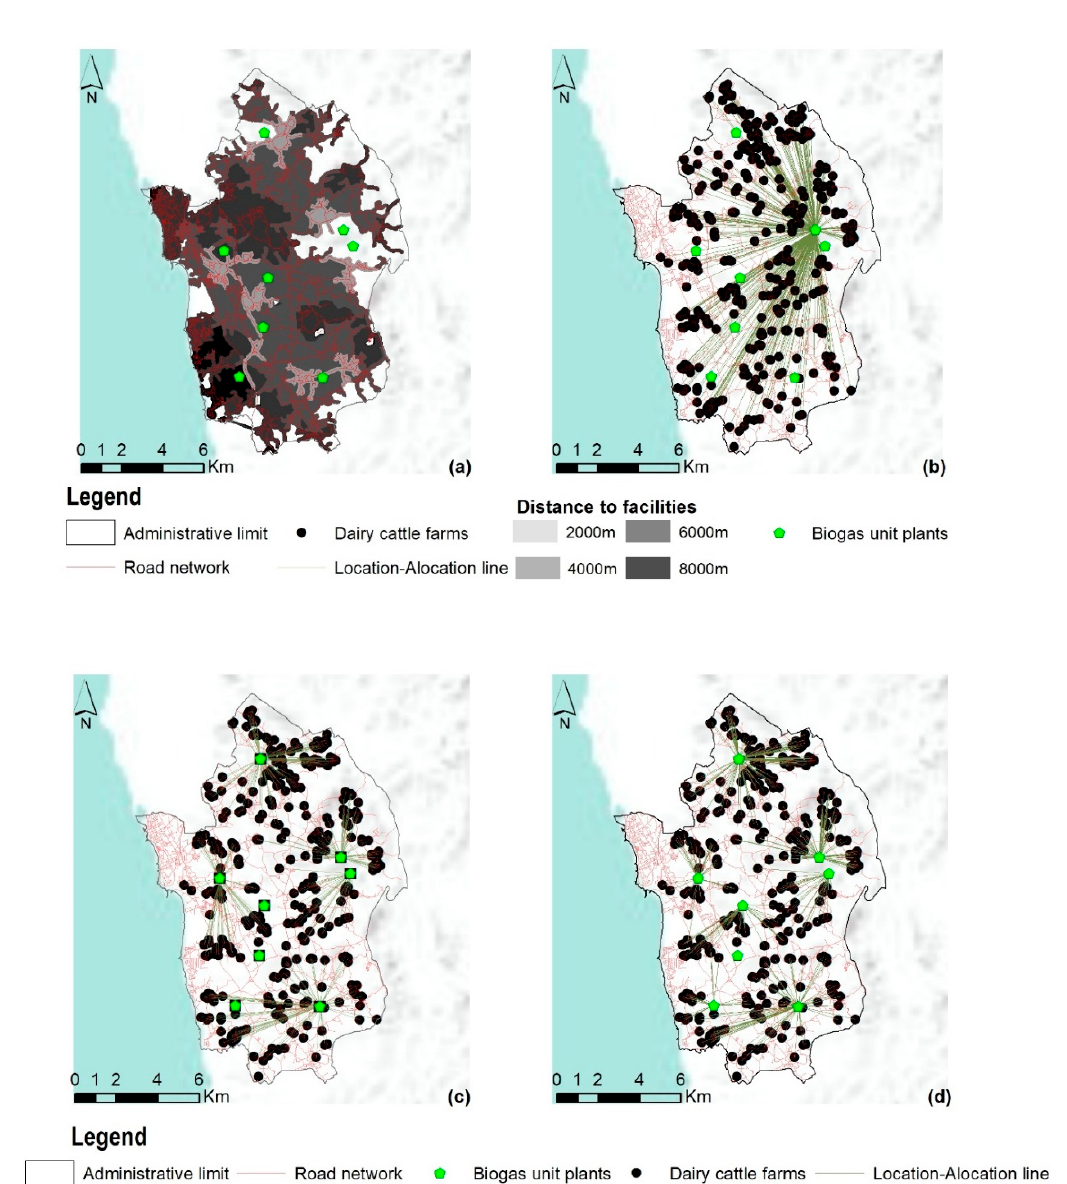
Figure 5. ( a ) Distance road analysis (m) to biogas plants; ( b ) Allocation analysis considering centralized (1 biogas facility); ( c , d ) distributed scenarios (5 and 8 facilities).